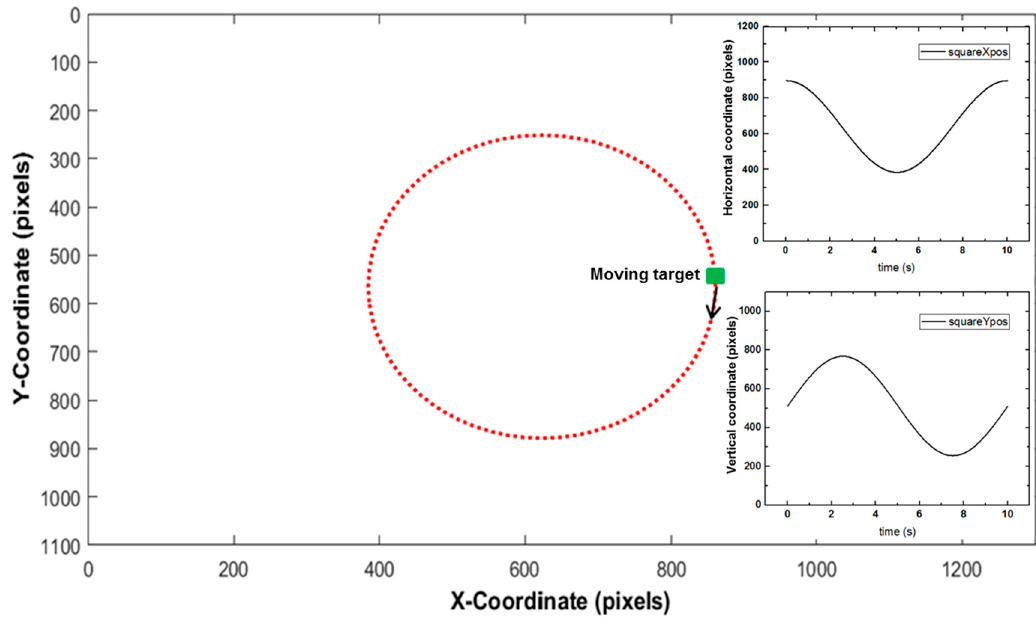
Figure 9. User stimulus signal (red dotted circle). Inset (top right): x -axis movement positions of moving target on a full cycle. Inset (bottom right): y -axis movement positions of moving target on a full cycle.